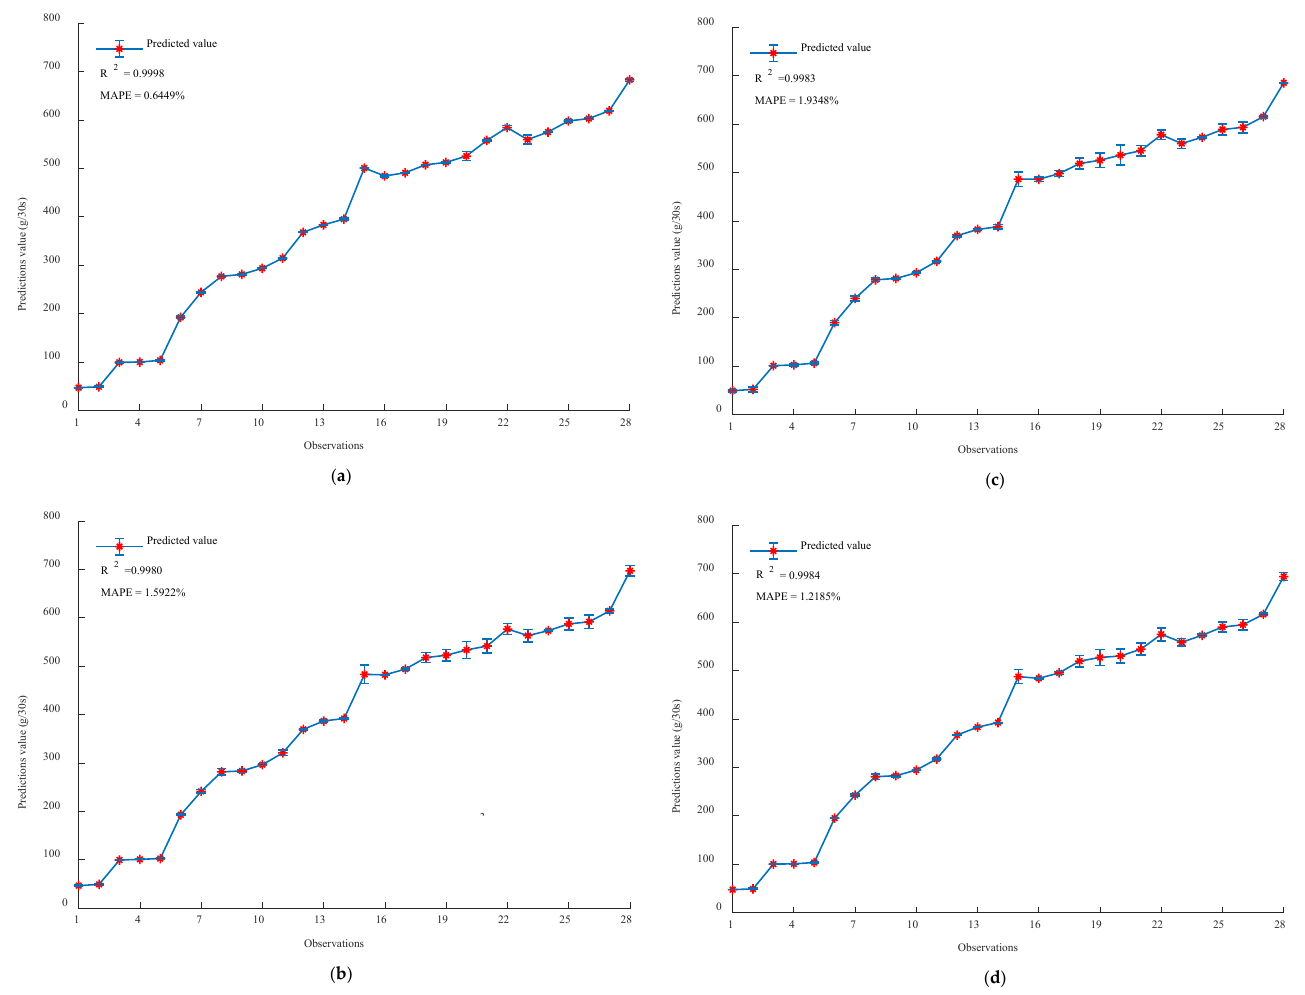
Figure 6. Deviations between the experimental data and predicted data for four machine learning algorithms with an opening length range of 8–28 mm: ( a ) BPNN; ( b ) ELM; ( c ) RVM; ( d ) SVM. The optimal models (SVM and BPNN) for the above two data segments are selected to predict the fertilization rate at the opening length of 8 mm, respectively, and the relative errors between the predicted value and the actual fertilization rate of the two models are compared, as shown in Table 7. The average relative errors of the SVM-based model for segment A and the BPNN-based model for segment B are 0.019824% and 0.007116%, respectively. It can be seen that the deviation between the predicted value and the actual value of the data in segment B is less than that of segment A. Therefore, the final fertilization rate prediction model is established as follows: